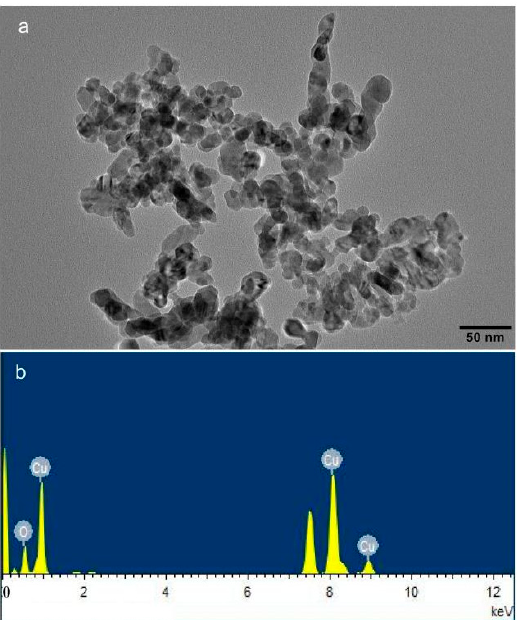
Figure 1. Characterization of nano-CuO: ( a ) TEM micrograph of nano-CuO; ( b ) spectrogram of the selected area.